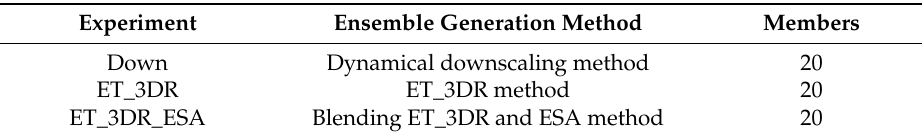
Table 1. Schemes for different ensemble forecast